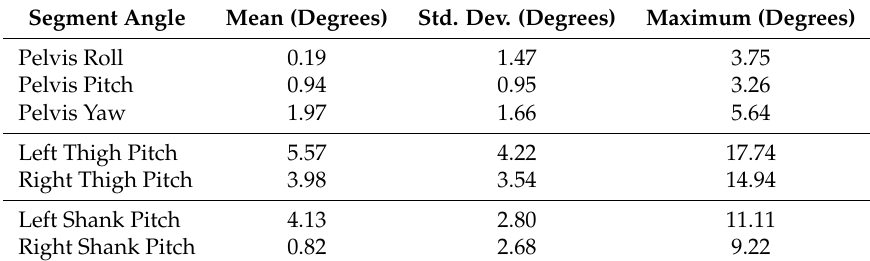
Table 3. Statistics of estimated orientation